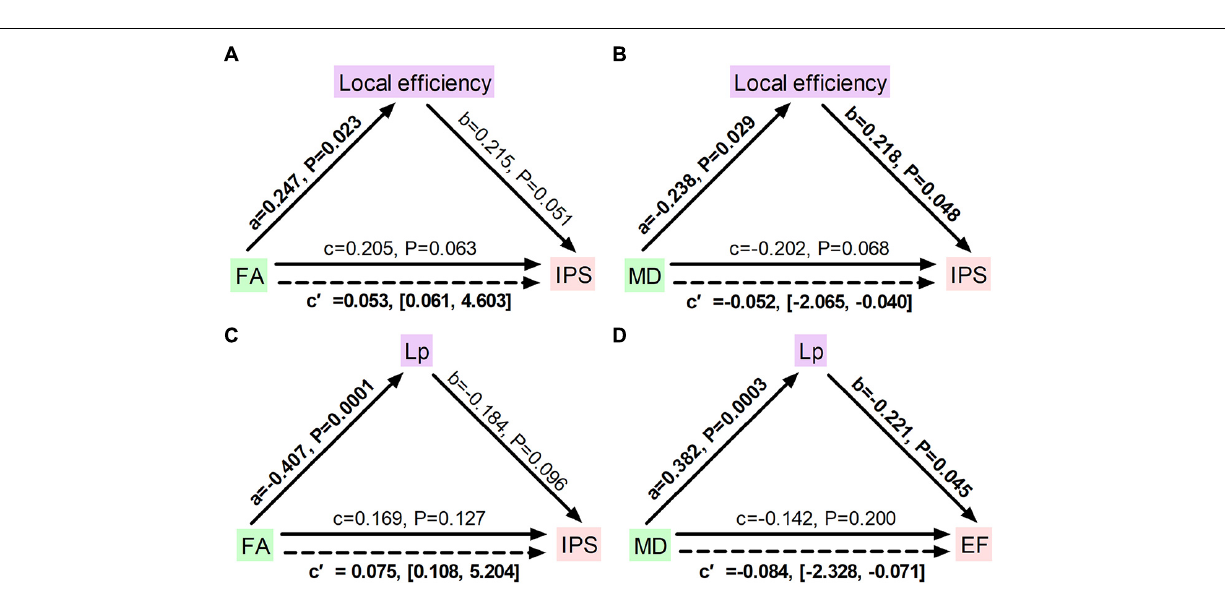
FIGURE 5 | Diagrams illustrating statistical mediation of the association between FA and MD measures and cognition by network properties in ILA. (A) Association between FA and information processing speed was significantly mediated by local efficiency. (B) Association between MD and information processing speed was significantly mediated by local efficiency. (C) Association between FA and information processing speed was significantly mediated by characteristic path length. (D) Association between MD and executive function was significantly mediated by characteristic path length. For each connection, the standard regression coefficient (standardized β ) and 95% confidence interval of the indirect mediation effect (c’) were shown. Solid lines represent direct effects (c); dashed lines represent indirect effects (c’). Significant pathways appear in bold. L p , characteristic path length; FA, fractional anisotropy; MD, mean diffusivity; IPS, information processing speed; EF, executive